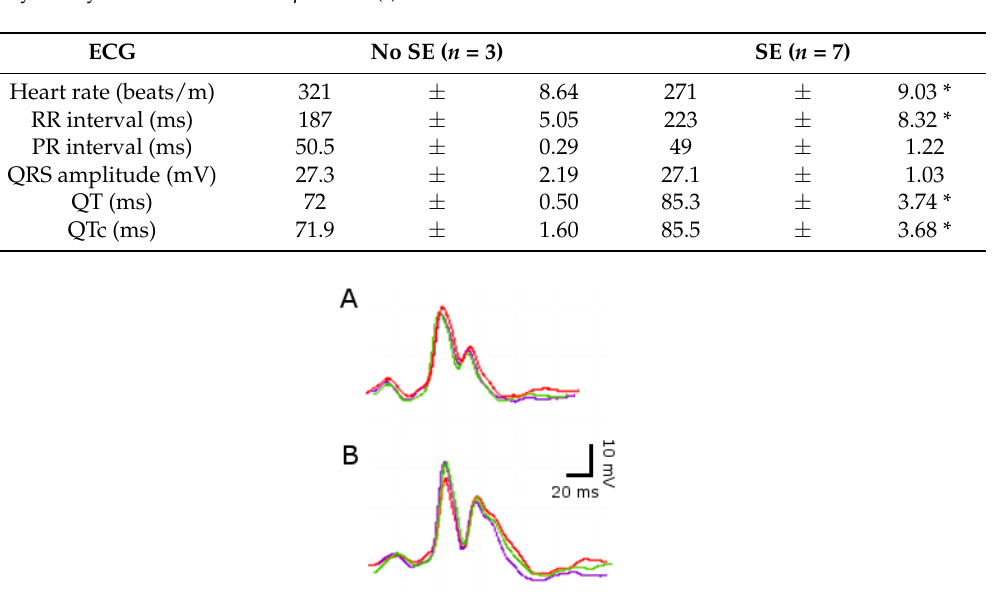
Table 1. Electrocardiograph (ECG) after one SE. Table shows the most common parameters of an ECG to control group (No SE) and convulsive group (SE). QTc parameter represents QT time corrected by the Bazzet normalized equation. The values are listed as mean ± standard error and differences were analyzed by Student t -test with p < 0.05 (*).